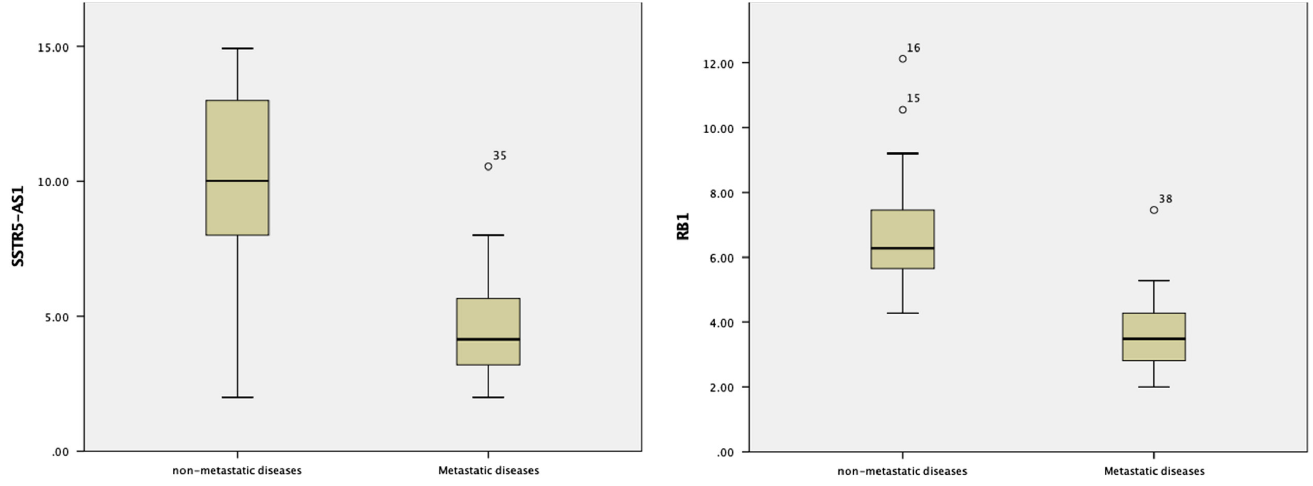
Figure 2. Kaplan–Meier estimates of time to castration-resistant prostate cancer in prostatic cancer patients who received androgen deprivation therapy as therapy of prostate cancer for expressions of RB1 and